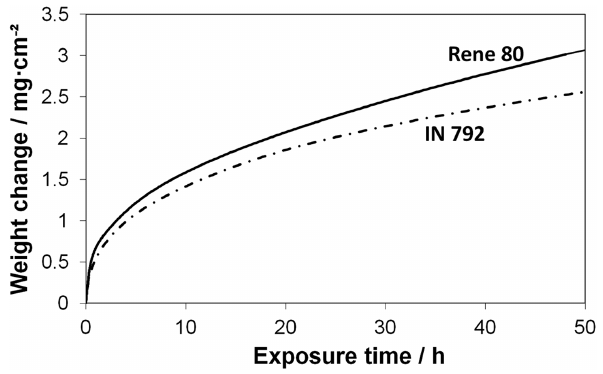
Figure 2: Mass gain plot obtained during isothermal oxidation of Rene 80 and IN 792 at 1,050°C for 50 h in Ar – 20% O 2.